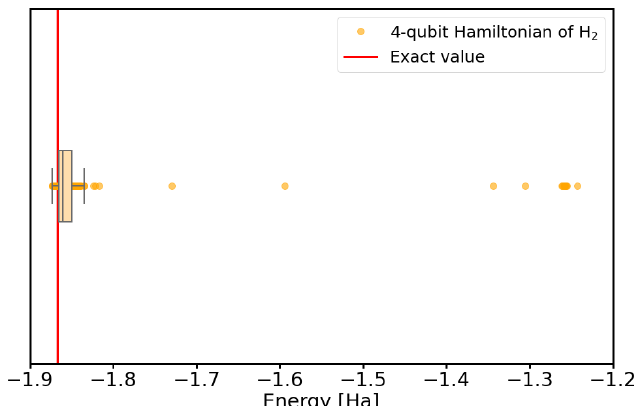
Figure A1. Ground-state energies of the H 2 molecule from 200 calculations on a noise-less simulator, using the 4-qubit Hamiltonian